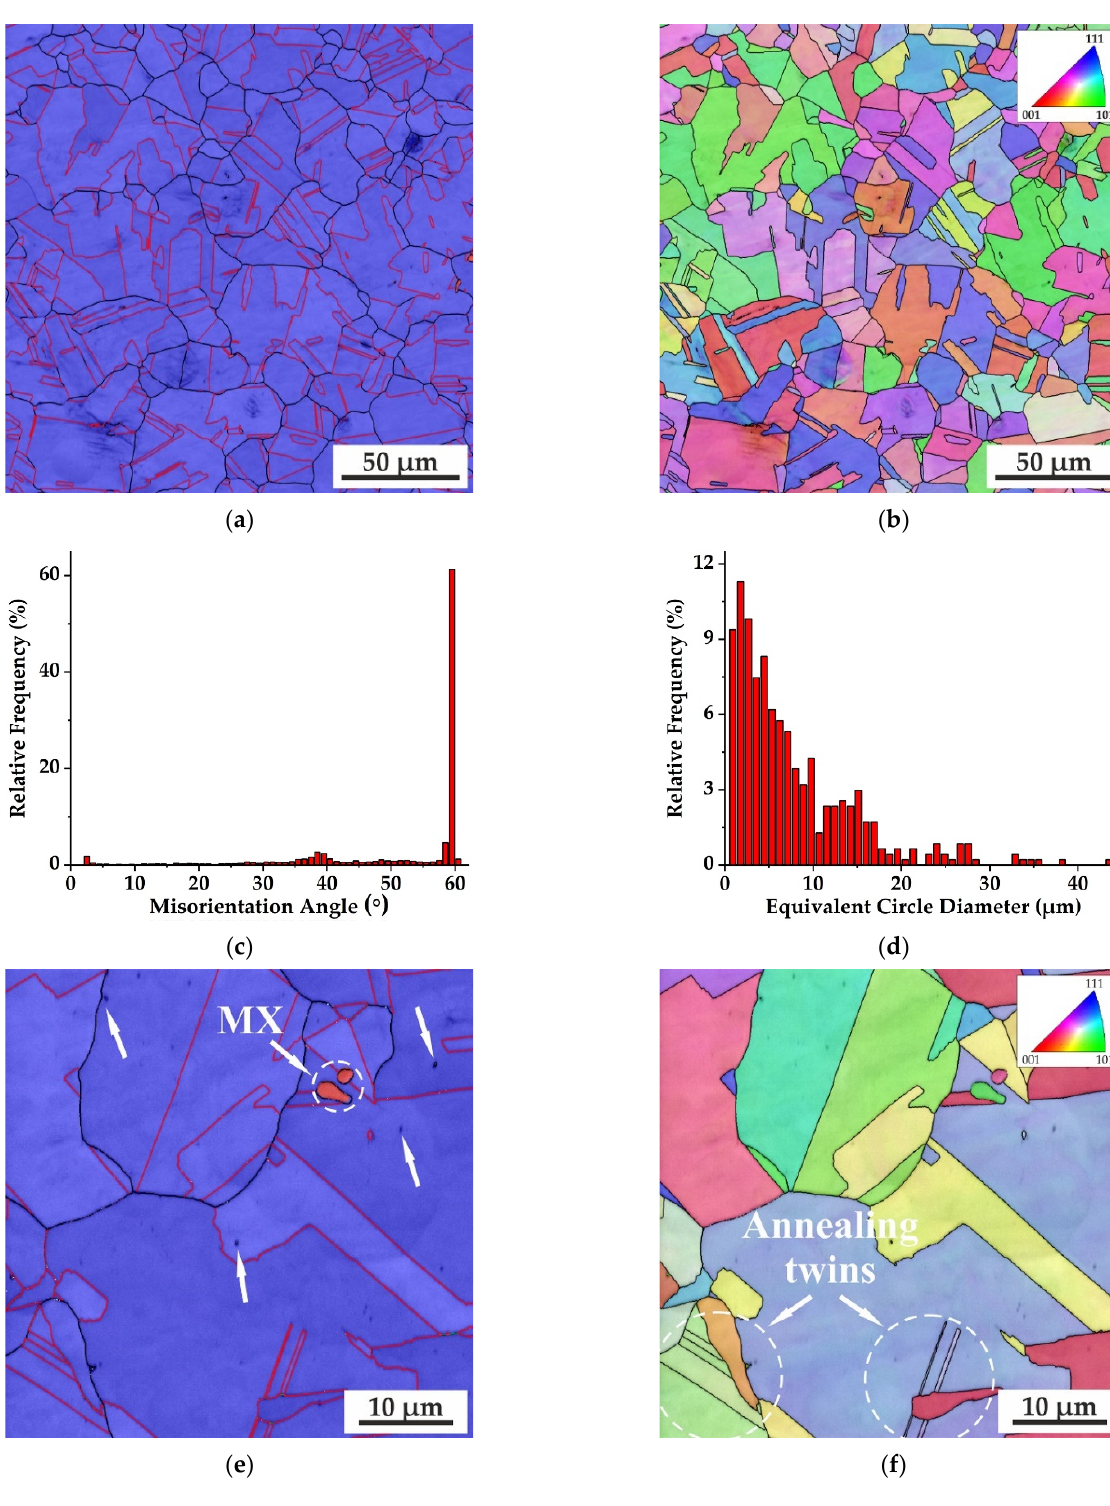
Figure 2. SEM Electron backscatter diffraction (EBSD) images of the steel solution-treated microstruc- ture. Phase map, where austenite is in blue color, carbides is in red color, high-angle, and twin boundaries are denoted by black and red lines, respectively ( a , e ); orientation map ( b , f ), grain misori- entation distribution ( c ), grain sizes distribution ( d ). The arrows indicate fine and coarse carbides of MX type ( e ) and annealing twins ( f